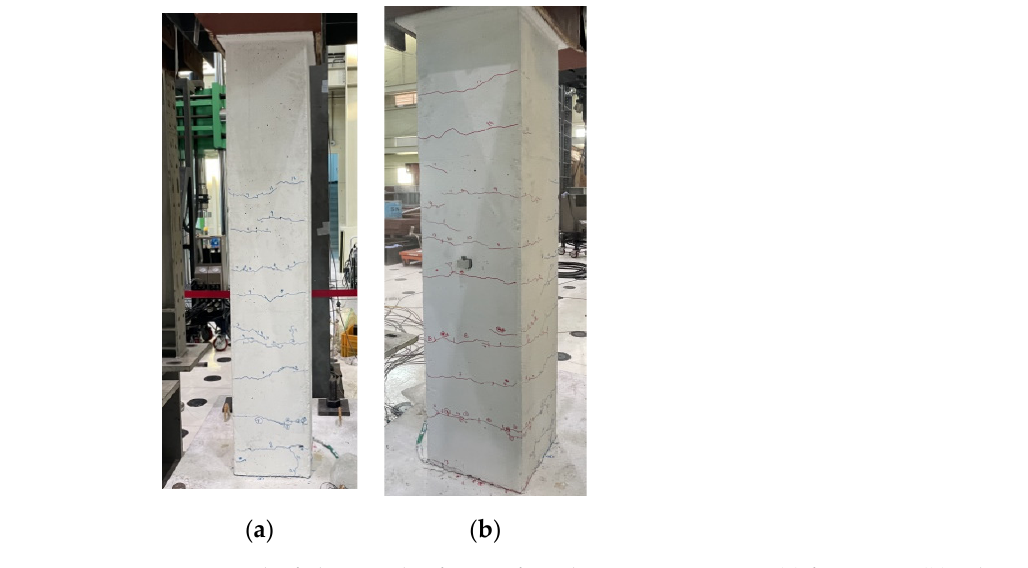
Figure 5. The failure mode of unreinforced H-series specimen. ( a ) front view, ( b ) side view.